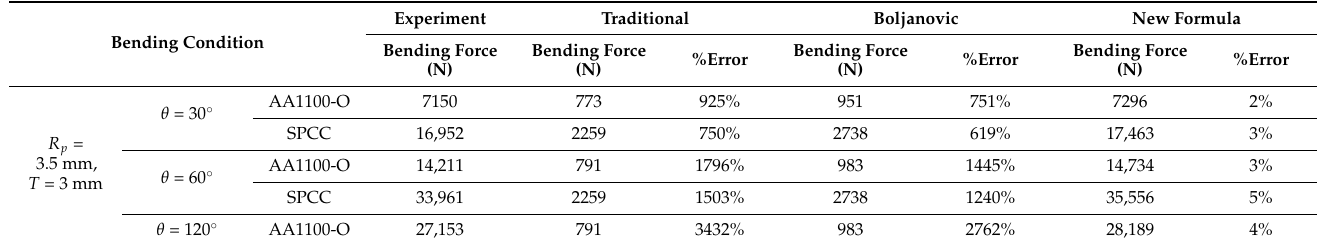
Table 3. Comparison of V-die bending forces calculated using traditional, Boljanovic, and new formulas, and those obtained by